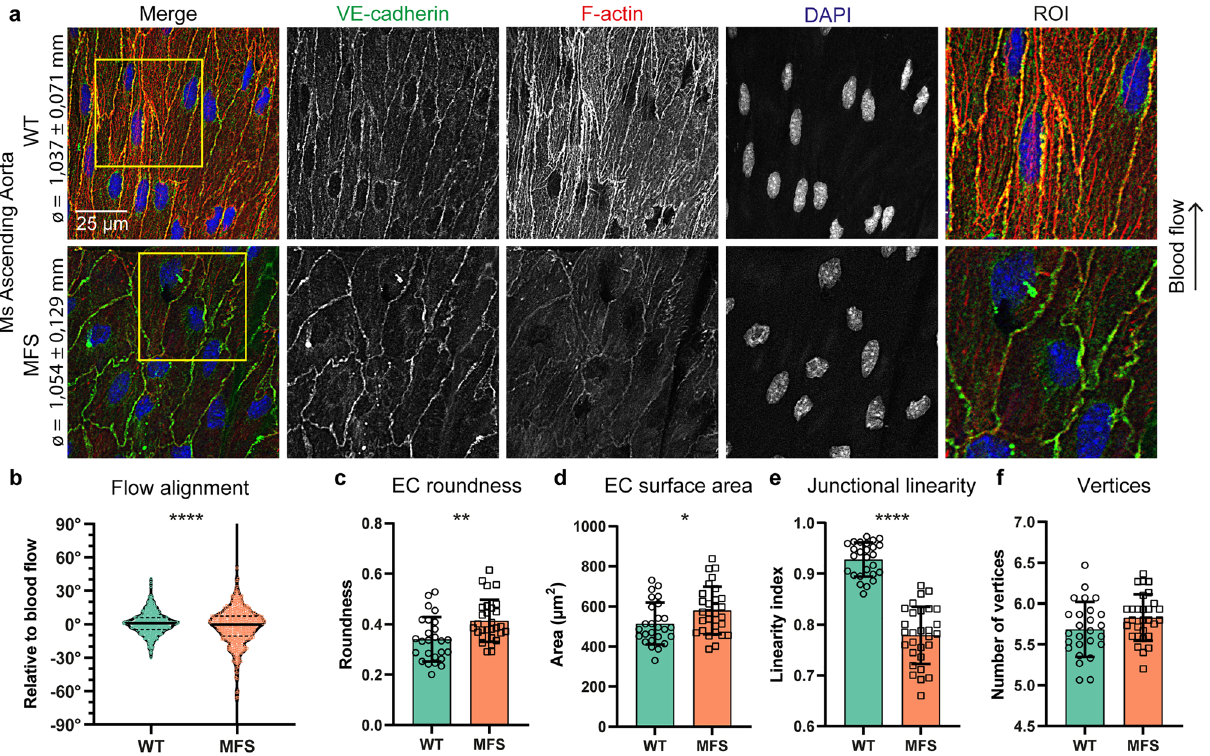
Figure 1. MFS ECs have altered morphological characteristics in the pre-dilated ascending aorta. ( a ) Representative en face IF confocal images showing VE-cadherin (green), F-actin (red), and DAPI (blue) of ascending aorta from 9 weeks old Fbn1 C1041G/+ MFS mice and WT littermates indicated with aortic diameter. Region of interest (ROI) highlights EC junctional linearity. Arrow indicates the direction of blood flow. Scale bar: 25 μm. ( b ) Violin plot showing quantification of EC alignment normalized to the direction of flow. Data distribution is tested by Kolmogorov–Smirnov test, **** p < 0.001. ( c – f ) Bar plots of EC morphology parameters in the ascending aorta from 9 weeks old Fbn1 C1041G/+ MFS mice and WT littermates. All data represents mean ± SD with indicated datapoints for WT (N = 6; M/F = 3/3) n = 25 images (total 424 ECs) and MFS (N = 6; M/F = 4/2) n = 33 images (total 555 ECs), * p < 0.05, ** p < 0.01, **** p < 0.0001 analyzed by students